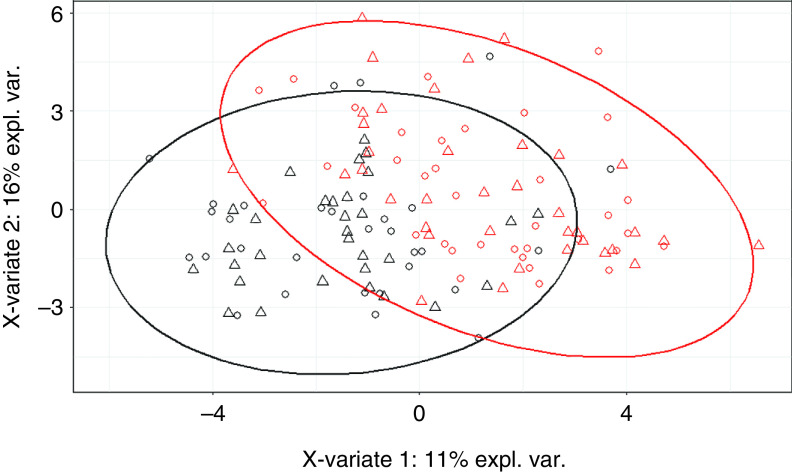
Multivariate integrative sparse partial least squares discriminant analysis based on pathways abundance at 119 days (○) and 140 days (Δ). Pigs receiving a deoxynivalenol (DON)- and zearalenone (ZEN)-contaminated diet (in red) were discriminated from the control pigs (in black) with 27 pathways and 15% error rate of misclassification. Expl. var. refers to t amount of variation explained per component.